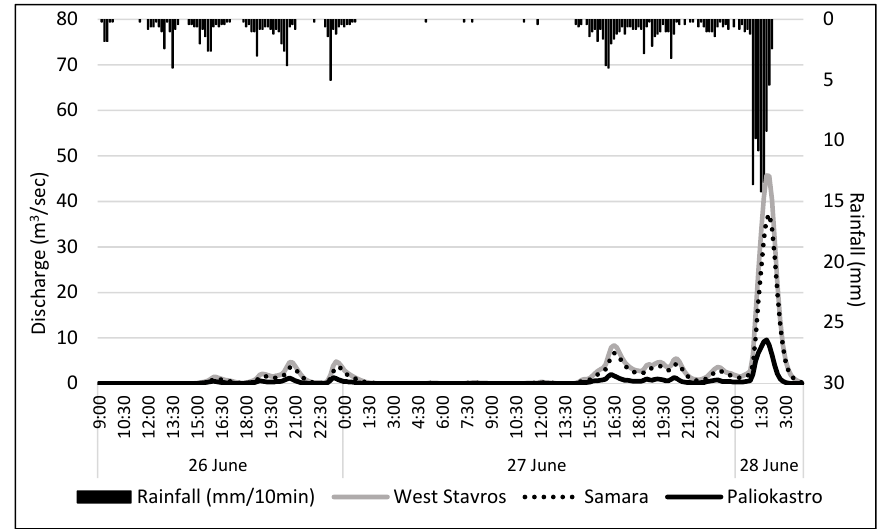
Figure 14. Simulated hydrograph of the June 2018 flood event at Kryoneri stream (east Stavros). Hydrology 2020 , 7 , x FOR PEER REVIEW